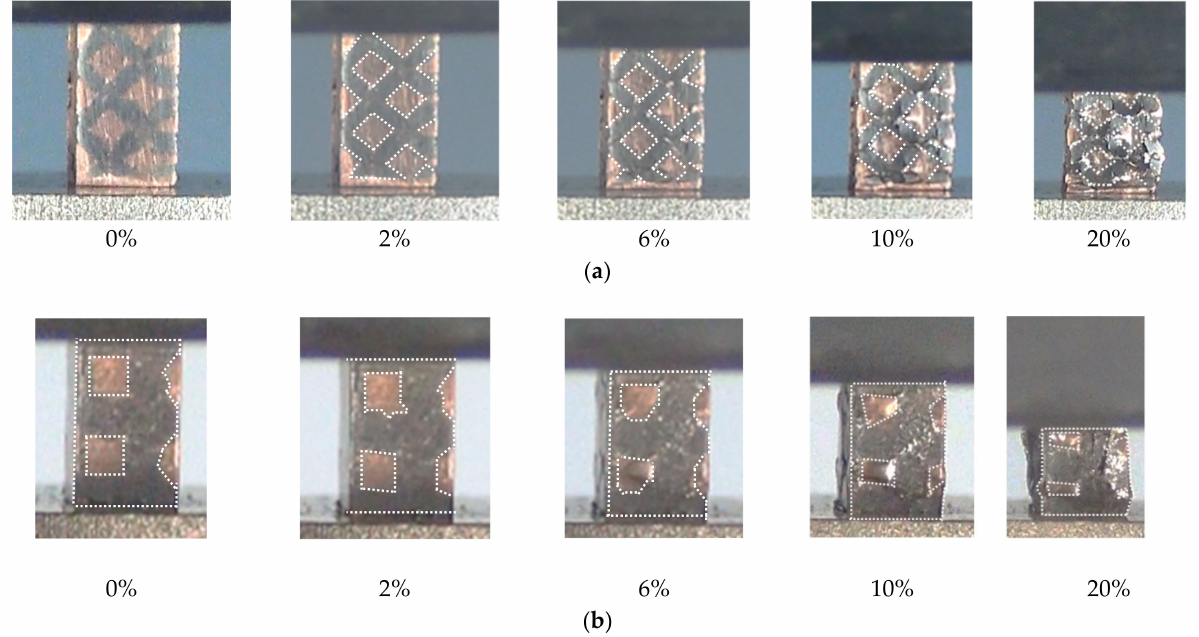
Figure 10. The deformation images of the Cu-W composites with the rhombic dodecahedron ( a ) and cubic ( b ) skeleton at different strains under uniaxial